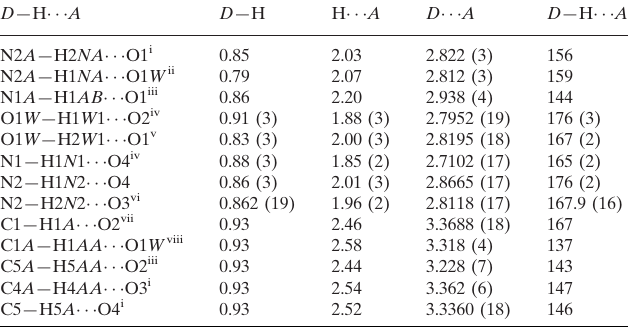
Hydrogen-bond geometry (A˚ , (cid:4)